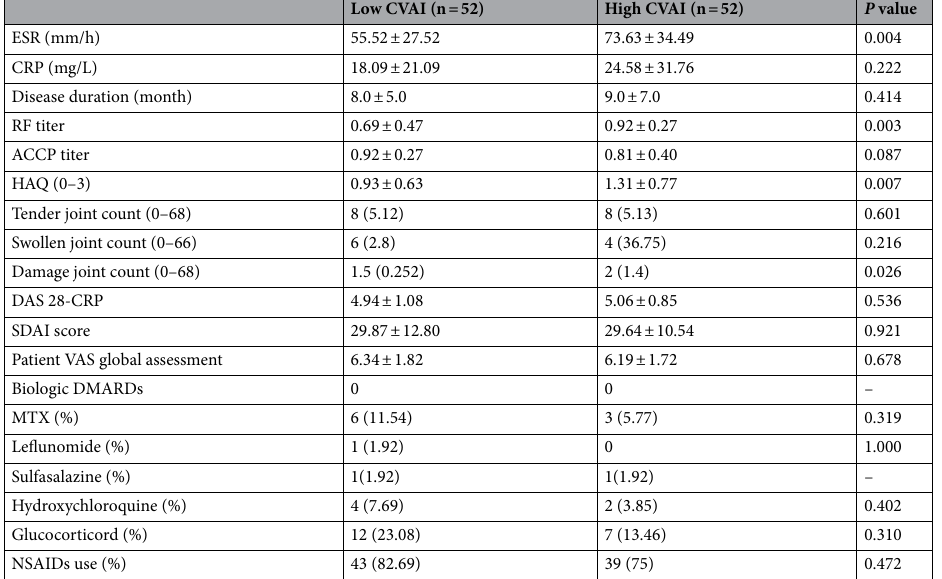
Table 2. Clinical characteristics of female ERA subgroups divided according to the median of CVAI (65.73). CVAI: Chinses visceral adiposity index; low CVAI group (< 65.73); high CVAI group (≥ 65.73). ERA: early rheumatoid arthritis; ESR: erythrocyte sedimentation rate; CRP: C- response protein; RF: rheumatoid factor; ACCP: Autoantibodies binding to citrullinated antigens; HAQ: Health Assessment Questionnaire; DAS 28-CRP: Disease Activity Score in 28 joint for CRP; CRP: C- response protein; SDAI: Simple Disease Activity Index Score; VAS: visual analogue scale. NSAIDs: non-steroidal anti-inflammatory drugs. P value: low CVAI & high CVAI.